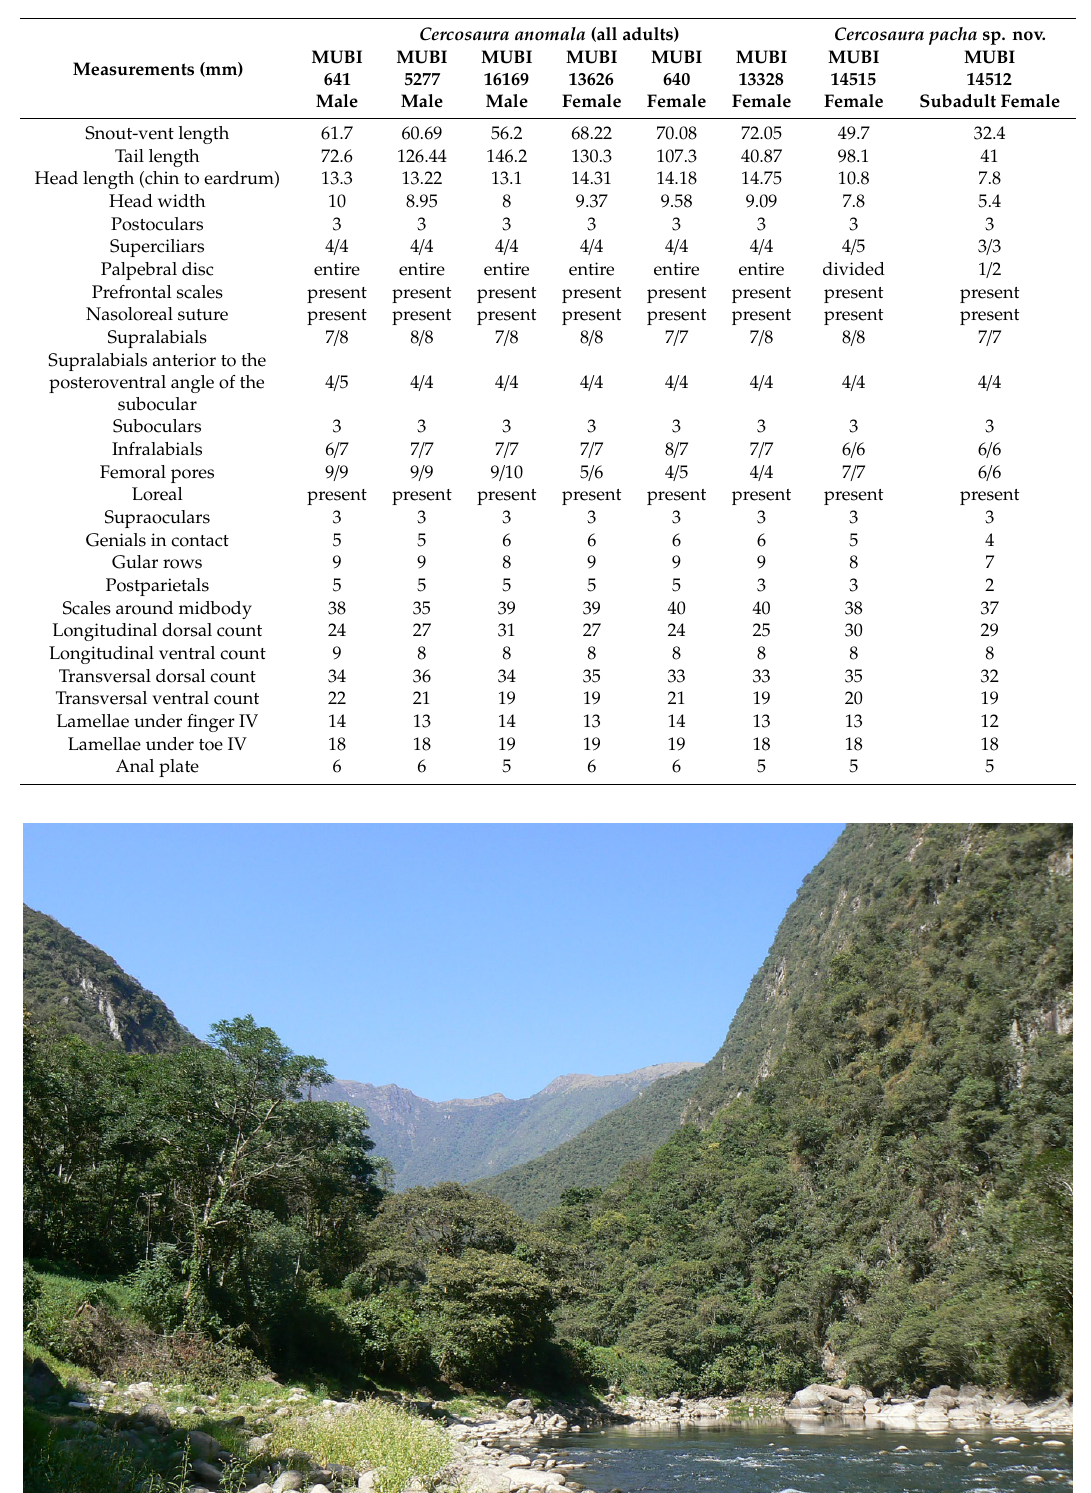
Table 5. Morphometric measurements and pholidosis of Cercosaura anomala and C. pacha sp. nov.